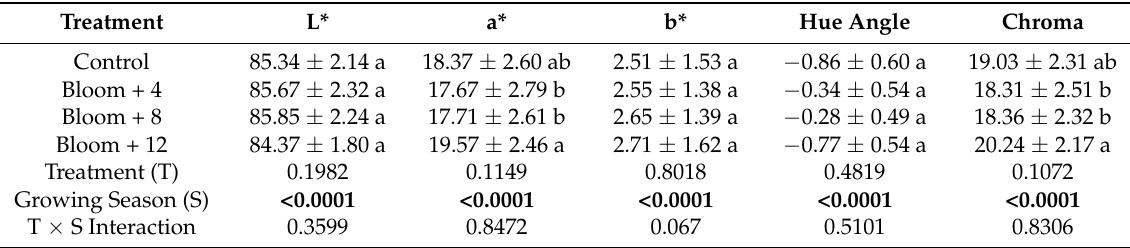
Table 6. Two-way analysis of variance (ANOVA) with interaction showing mean values and p -values of wine CIE L*a*b* chromatic parameters post-malolactic fermentation by cluster thinning treatment. Combined two-year averages followed by standard error of the mean. Also shown are p -values corresponding to main effects and the interaction between treatments and growing season ( n = 3). Different letters within a column indicate significant differences between treatment groups for Fisher’s LSD at p < 0.05. p values below 0.05 are shown in bold